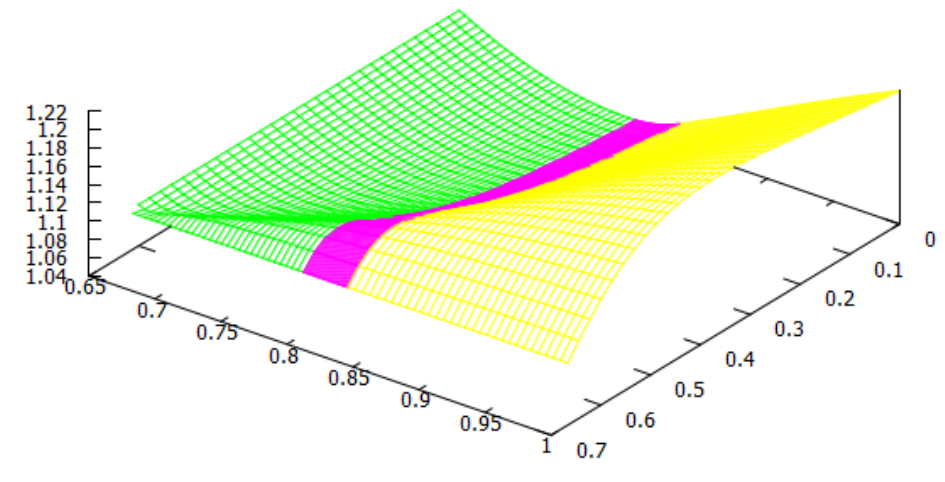
Figure 7. The trade agreement index g . See Equation